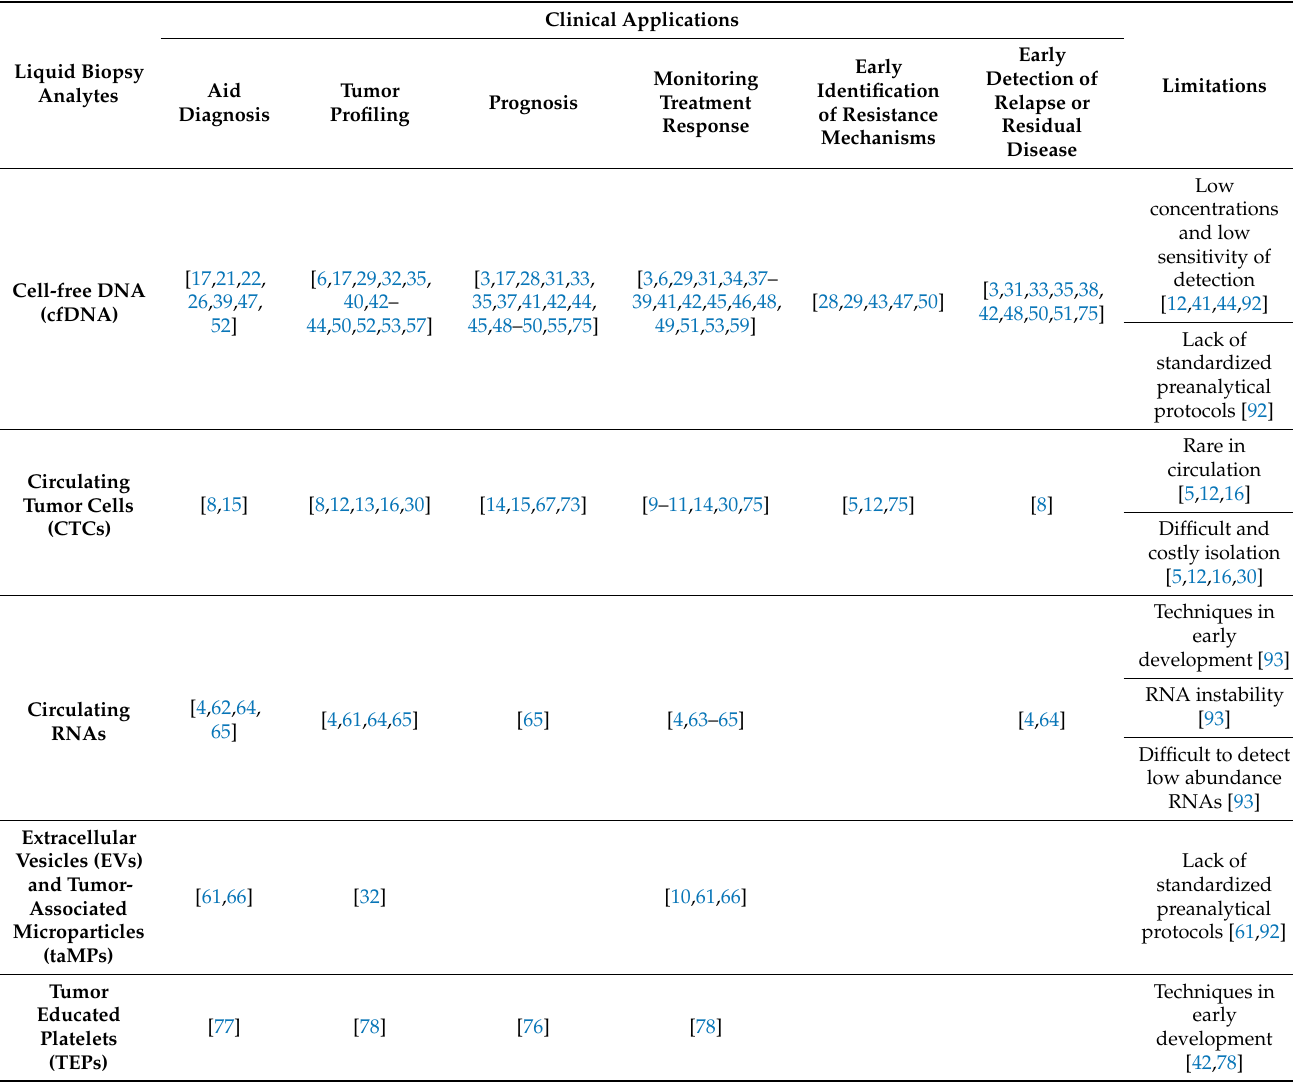
Table 2. Clinical applications and limitations of different liquid biopsy